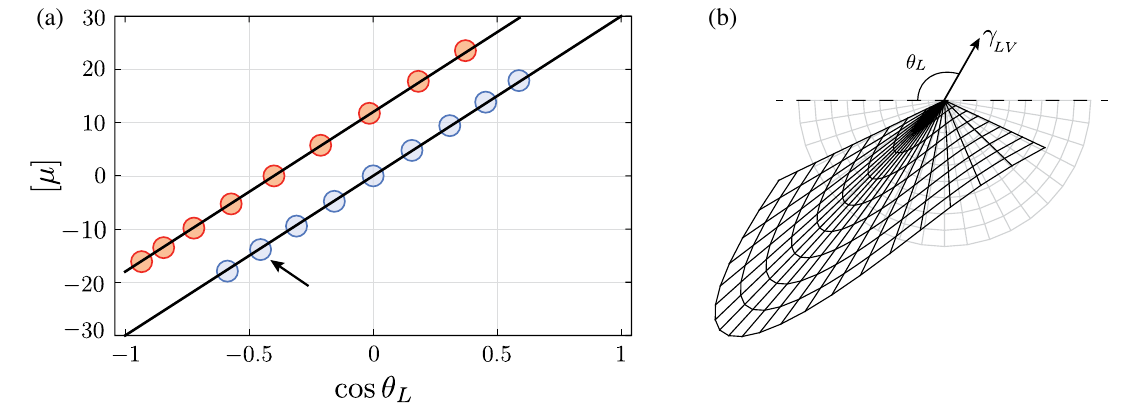
FIG. 7. (a) The strength of the surface defect, quantified by the discontinuity of chemical potential ½ μ (cid:2) þ − , plotted versus the liquid contact angle θ . Solid lines are from the theoretical prediction (39), open symbols from FEM with the Shuttleworth effect L ¼ γ ¼ γ ¼ 90 °. Red data: ( c 0 ¼ c 1 ¼ 1 ). Blue data: Symmetric surface energies γ 0 , so that the equilibrium angle θ 0 ; SL ; SV Y LV ¼ 4 = 5 γ ¼ 6 = 5 γ ¼ − 2 = 5 . The numerics Asymmetric surface energies γ 0 and γ 0 , so that based on λ ∞ ¼ 1 we find cos θ ; SV ; SL Y LV LV ¼ θ confirm that ½ μ (cid:2) þ − provides the pinning force; when pulling at θ , there is no pinning and ½ μ (cid:2) þ − ¼ 0 . (b) The grid plot represents the L Y > θ asymmetric ridge for symmetric surface energies, resulting from a contact angle θ . This ridge corresponds to the data point L Y marked by an arrow in the main